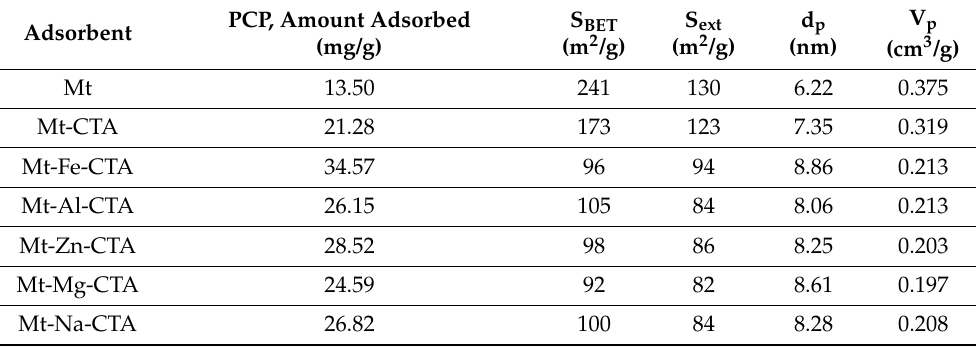
Table 1. Adsorption capacity of the adsorbent materials after 12 h of contact, C 0 = 10 mg/L, and textural properties of the